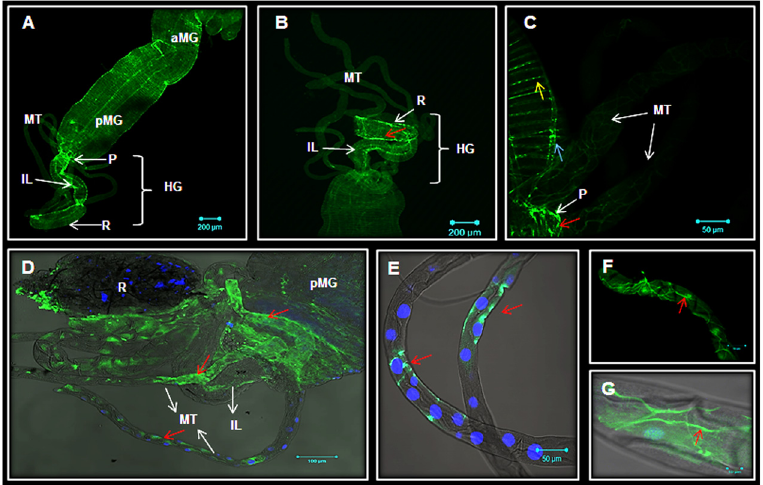
Fig 5. AaSer-1 expression in the visceral gut muscles and the MT of Aedes larvae. A low magnification image (A) is depicting AaSeR-1 specific immunofluorescence in Aedes gut muscles (Legend: aMG-anterior midgut, pMG-posterior midgut; MT ― Malpighian tubules; HG-hindgut; P-pylorus; IL-ileum; R-rectum). AaSeR-1 is also found in the HG (B; red arrow). Higher magnification image (C) is showing AeSeR-1 expression in both circular (yellow arrow) and longitudinal (blue arrow) muscles, as well as in the pylorus area (red arrow). AeSeR-1 immunofluorescence is also found in some principal cells of the MT (D-E; red arrow). Although still under investigation, specific immunofluorescence was detected in what appears to be the tracheolar network of the MT (F-G; red arrow). Scale bars ( μ M) are included in each